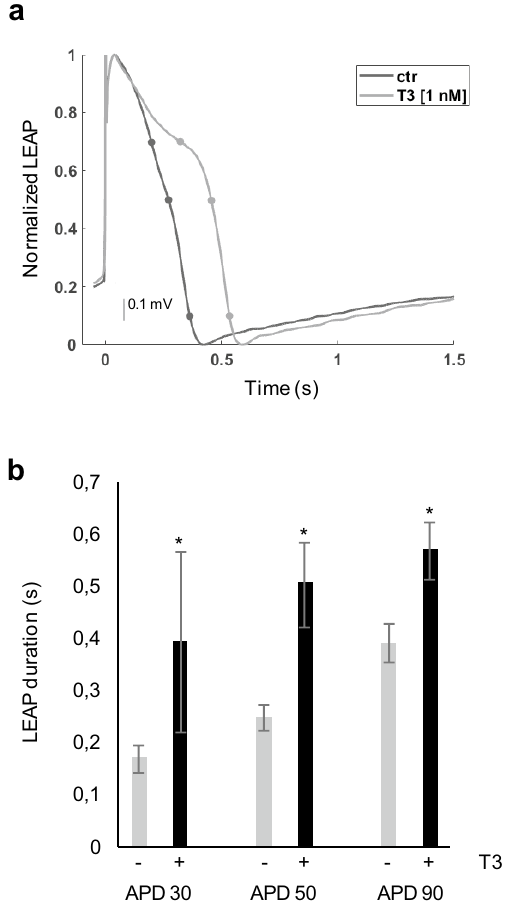
Figure 4. LEAP analysis of hiPSC-CM treated with T3. ( a ) Local extracellular APD analysis of iPSC-CM treated for 24 h with T3 1 nM. The amplitude normalized LEAP waveforms (averaged across 5 beats) from representative wells are overlaid for the vehicle control (grey) and the T3 1 nM (black) treated cardiomyocytes. ( b ) The histogram represents the mean ± standard deviation of APD30, 50, and 90 measured in four wells. *p <